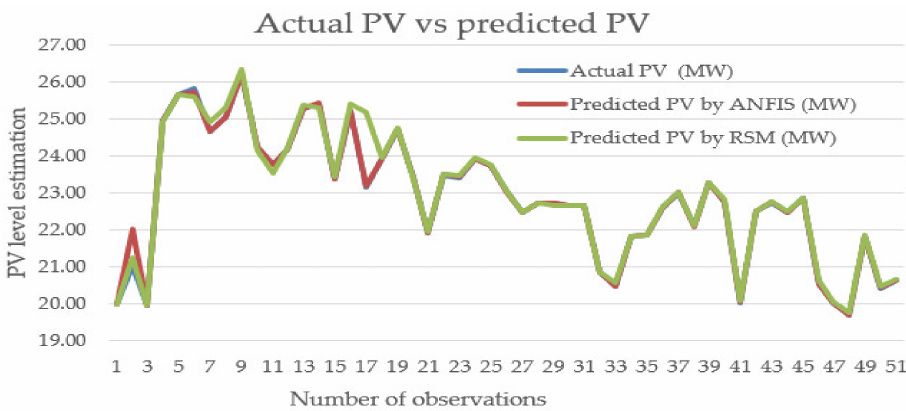
Figure 20. The comparison of actual and predicted solar PV generation model